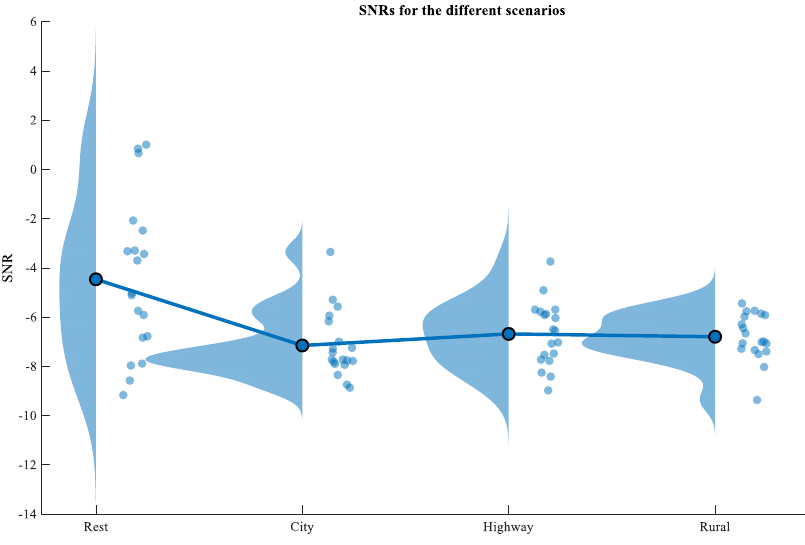
Figure 4. Distribution of the SNR for the different scenarios.